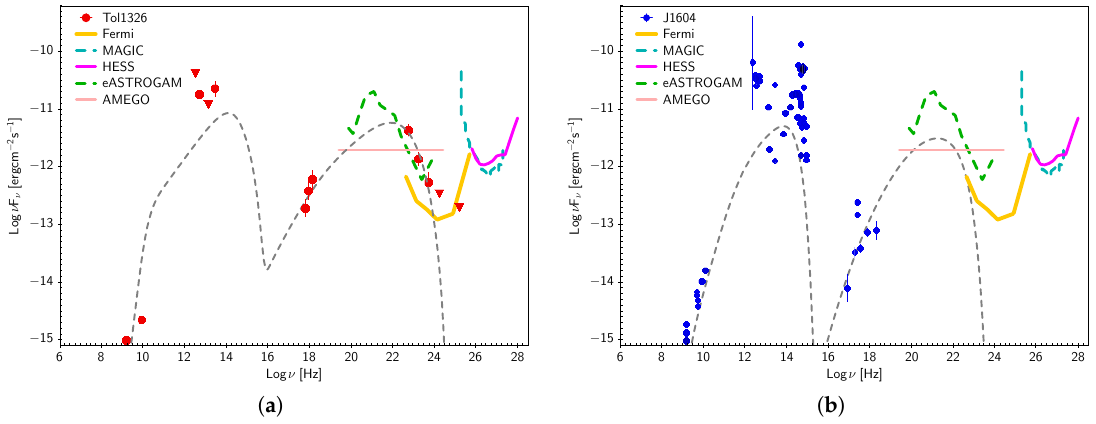
Figure 4. ( a ) the SED of Tol 1326-379 (red points), the only FR 0 observed by Fermi so far, is modelled with a one-zone synchrotron–SSC model (grey dashed line). Following the modelling presented in [83], a moderate viewing angle ( ∼ 30 ◦ ) and bulk motion ( Γ jet ∼ 2) have been assumed. ( b ) the SED of another FR 0, J160426.51 + 17 (blue points) with a model similar to that applied to Tol 1326-379 is shown (data from [28]). The expected sensitivity curves of current and future instruments in the MeV to TeV window are plotted (see the legend). While, in the framework of standard, one-zone leptonic models, a detection in the VHE range seems unlikely, both sources could be detected at MeV energies by future missions such as AMEGO [88] and e-ASTROGAM [89] (see Section